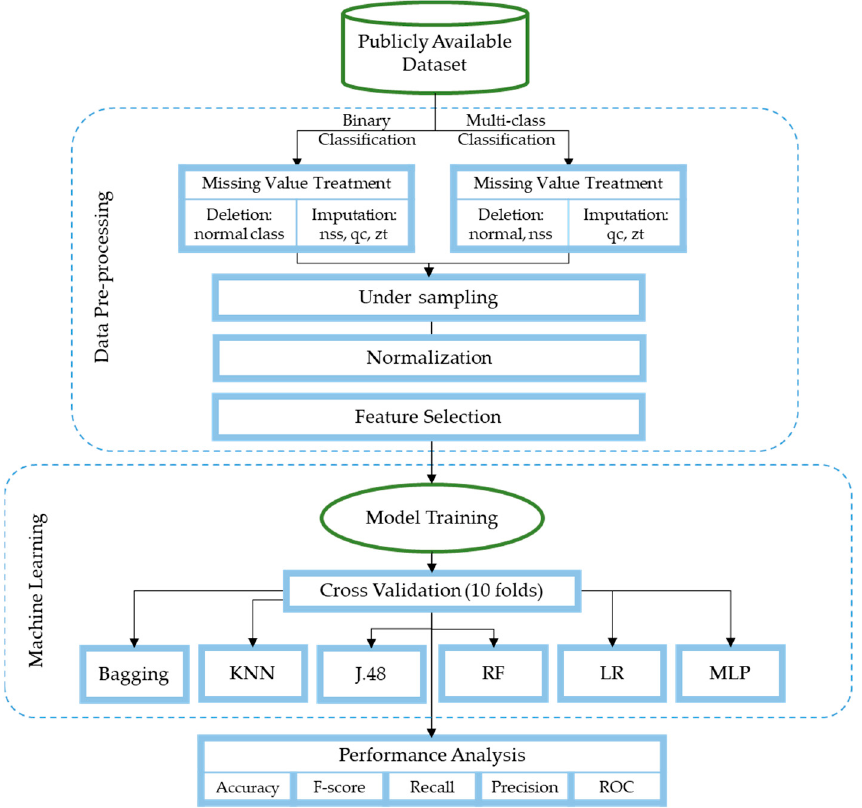
Figure 1. Research methodology